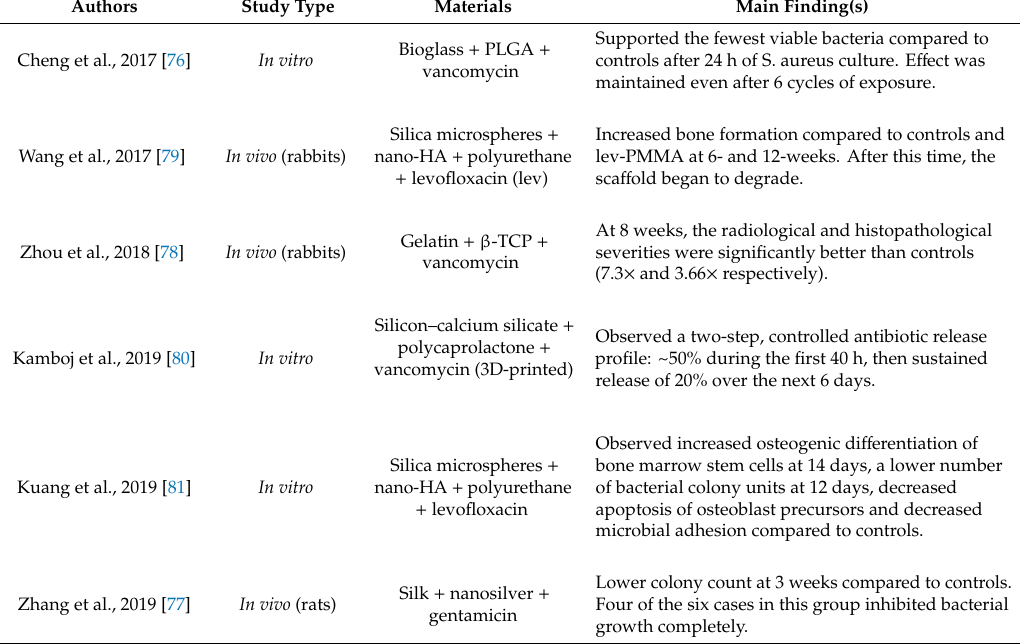
Experimental studies focusing on antibiotic-eluting, composite sca ff olds for chronic